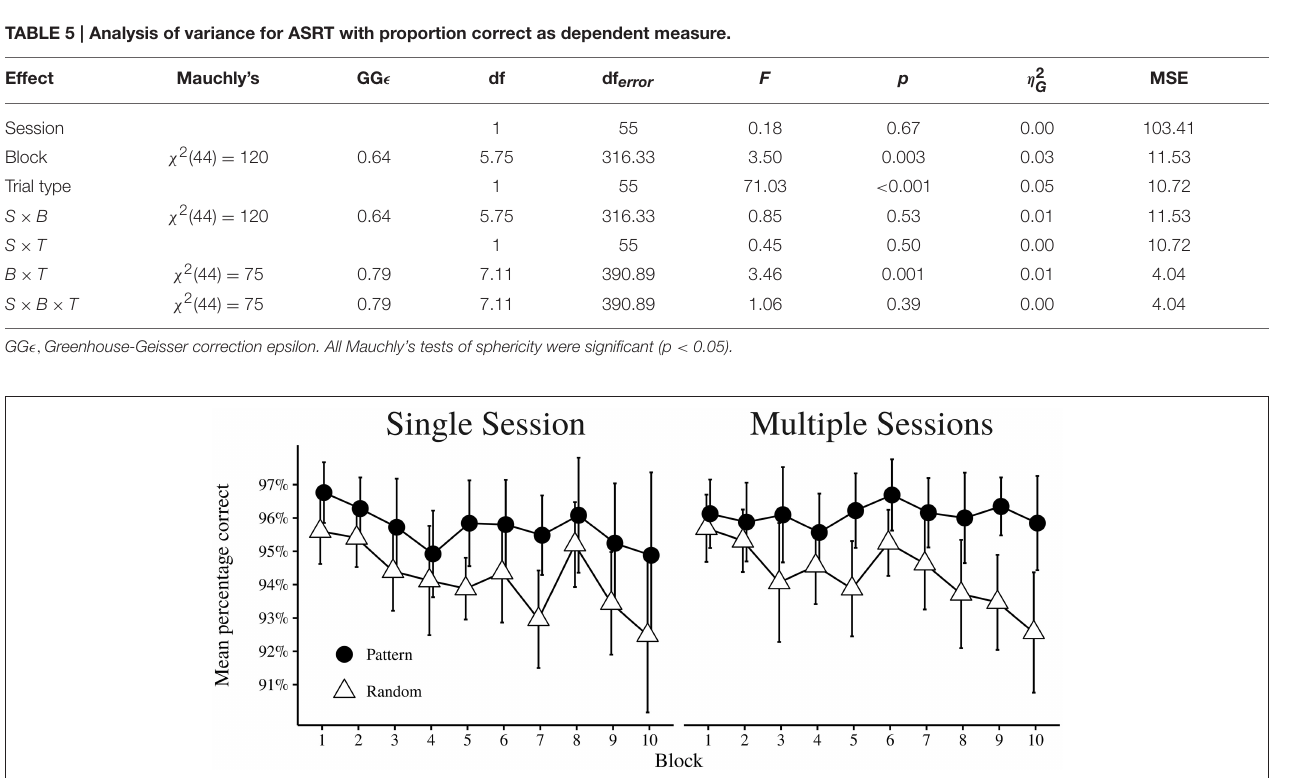
FIGURE 7 | Mean percentage correct trials of each block for pattern and random trial types, shown independently for each condition. Error bars indicate 95% CI.